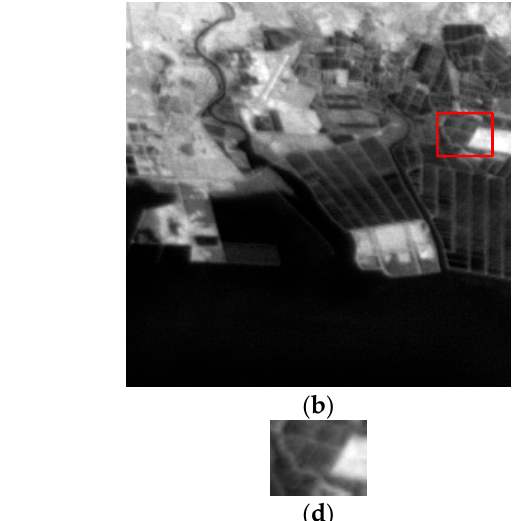
Figure 10. Results of image enhancement. ( a ) SR + image enhancement; ( b ) image enhancement of the reference image; ( c ) and ( d ) are the regions denoted by the rectangles in ( a ) and ( b ) respectively.